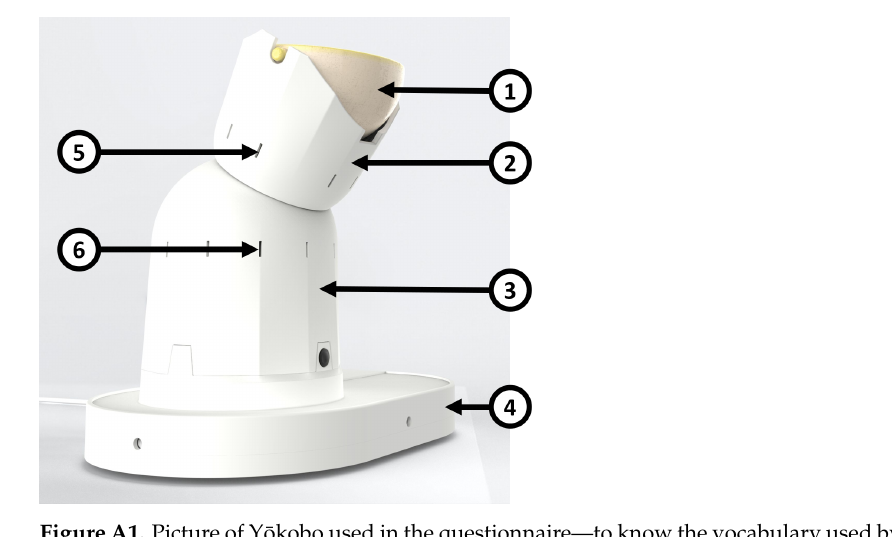
Figure A1. Picture of Y¯okobo used in the questionnaire—to know the vocabulary used by participants to describe the robot. The numbered marks refer to the question in Table A1. Table A2. Questions in QW2 for the selected participants. The text in square brackets was added to this article and was not present in the questionnaire.